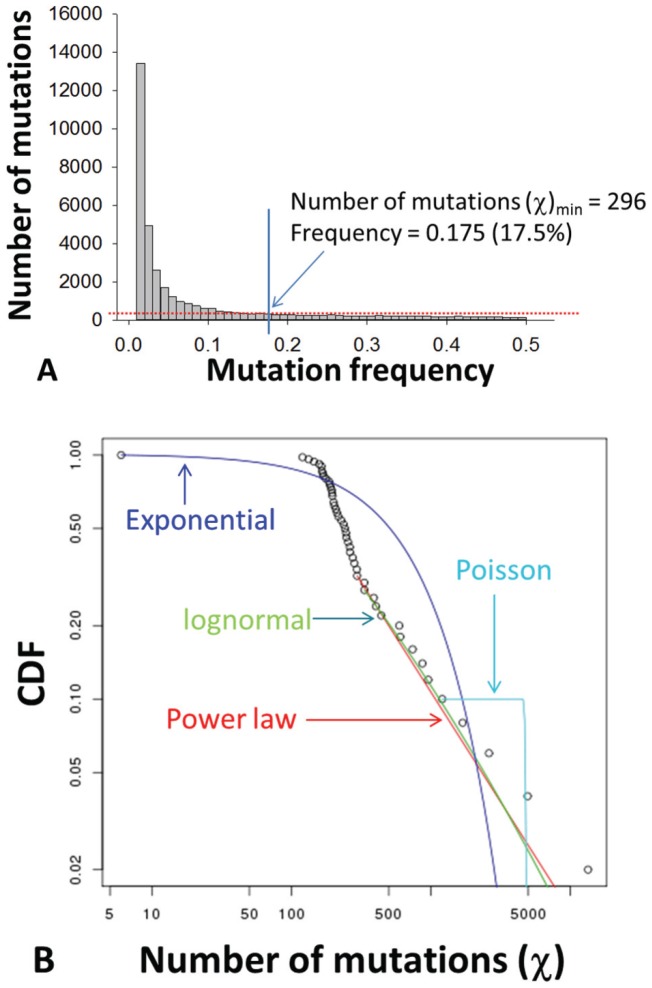
The mutation frequency-based histogram of a total of 36,665 mutations identified in 56 patients (A), which fitted in with a power law distribution (B) with the low-bound point (χmin) at 296, corresponding with a mutation frequency at 17.5% (A).CDF, cumulative distribution function.